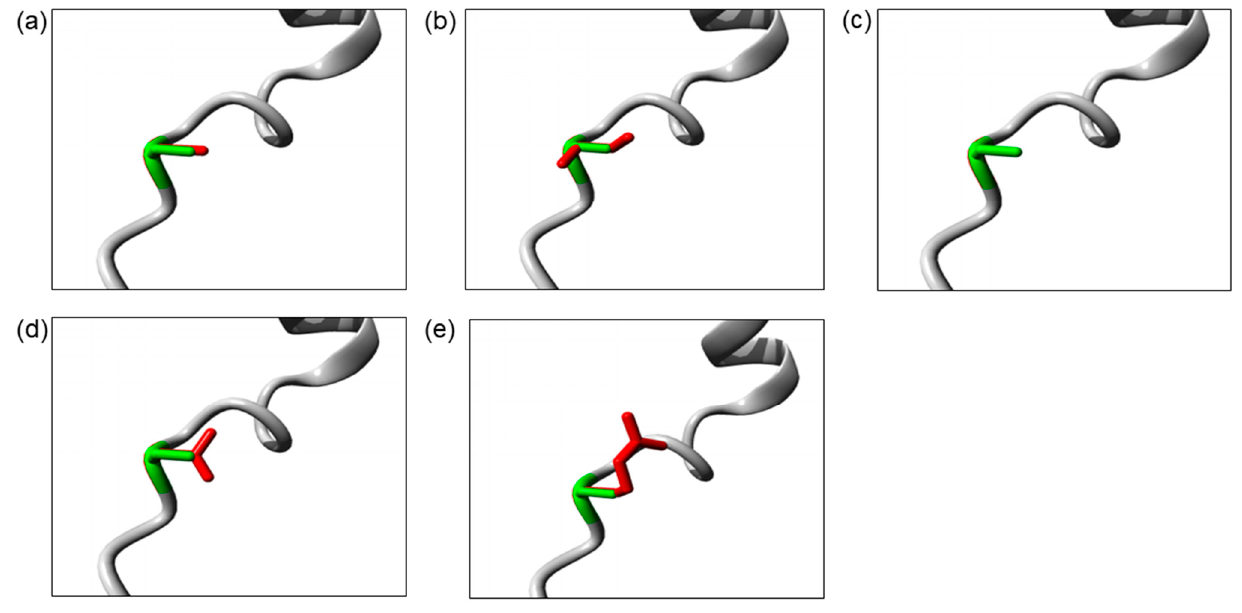
Figure 2. The close-up image of superimposed structure of wild-type and mutant residues. ( a ) Ser32Cys. ( b ) Ser32Ile. ( c ) Ser32Gly. ( d ) Ser32Asn. ( e ) Ser32Arg. The protein core is shown in gray while the amino acid side chain of the wild-type (green) and the mutant (red) residue are represented as sticks.